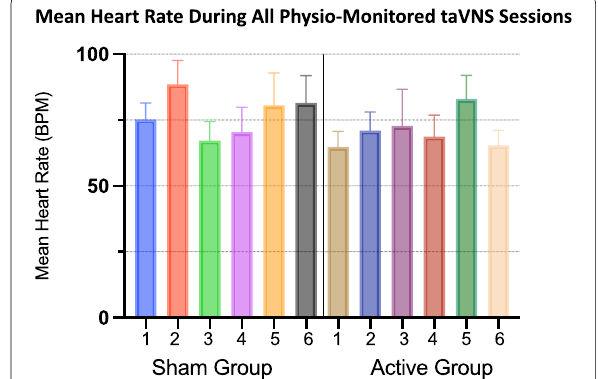
Fig. 4 Individual Participant Heart Rate Monitoring. We recorded the mean heart rate (error bars sem) during the first 6 taVNS sessions = in all participants. Regardless of stimulation condition, all participants maintained a safe mean heart rate and did not experience any bradycardia